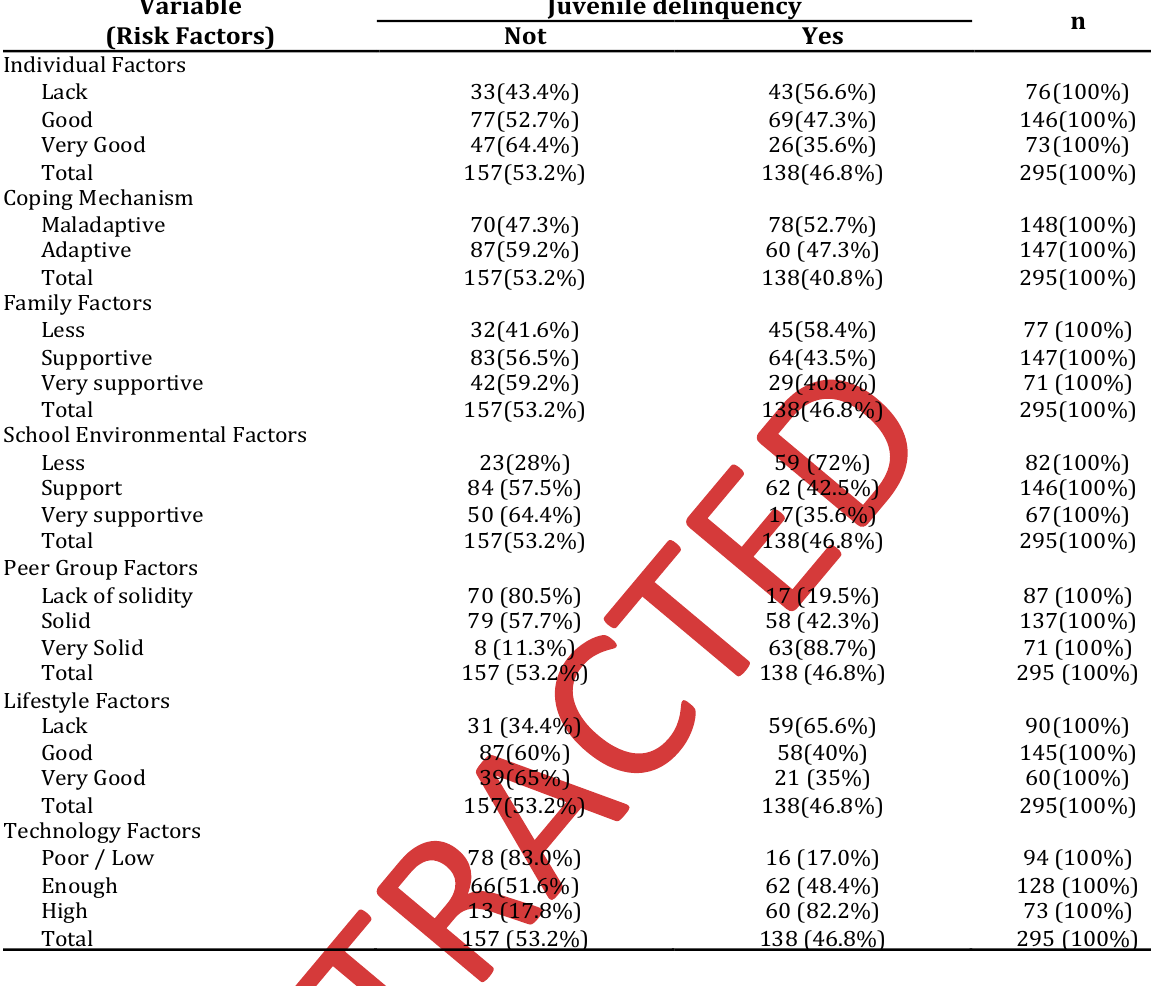
Table 2: Descriptive Analysis of the Seven Risk